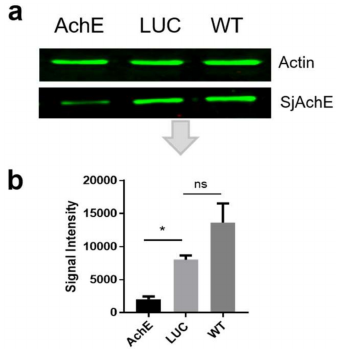
Figure 2. Effect of knockdown of SjAChE in intact adult S. japonicum worms treated with dsRNA for 4 days determined by Western blotting. ( a ) Anti-actin antibody (upper) and anti-SjAChE antibody (lower) were used to probe a protein extract of intact adult S. japonicum 4 days after treatment with SjAChE dsRNA (Lane 1); ds LUC (Lane 2); and without dsRNA (Lane 3); ( b ) signal intensities of bands recognised by anti-SjAChE antibody in panel a (bottom) were measured using the Odyssey Classic Infrared Imager with a scan intensity setting of 5 and a sensitivity of 5. Error bars represent the standard error of the mean (SEM). This experiment was performed twice. LUC , luciferase control group; WT, wild type unsuppressed control worms cultured in the same media; ns, no significant difference. * = p value ≤